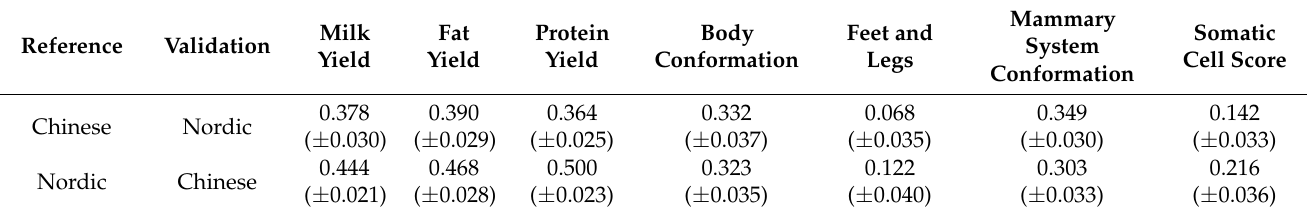
Table 6. Accuracy of the cross-population prediction in the 10 replicates of the five-fold